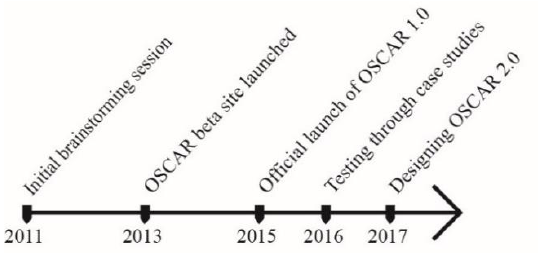
Figure 2. Timeline of OSCAR’s